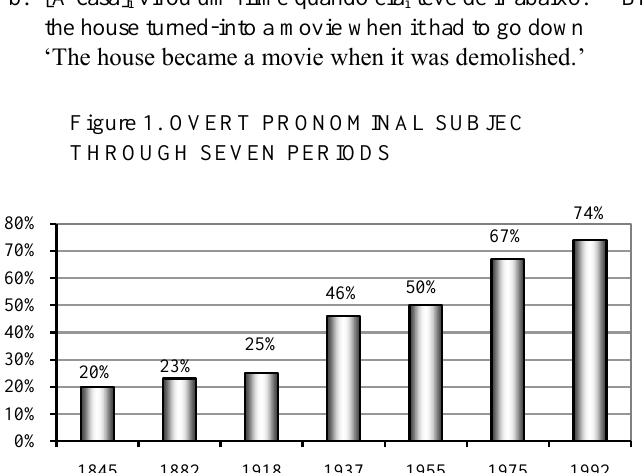
Figure 1 (adapted from Duarte 1993: 112) shows that the rate of overt pronominal subjects in the first half of the 19th century is 20%; by the end of the century this rate has increased to 74% 10